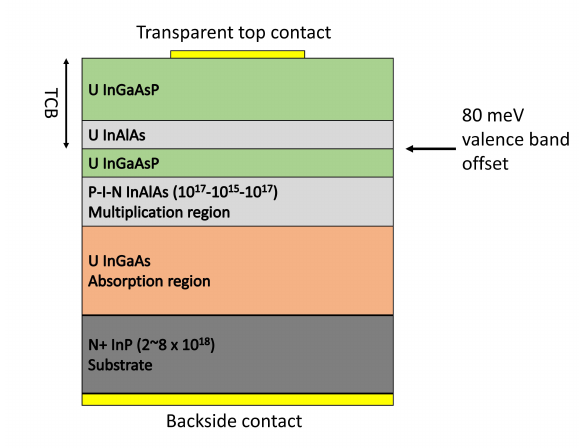
Figure 2: Epitaxial structure of a self-quenching InGaAs/InAlAs SPAD showing the InGaAs absorption region, InAlAs multiplication region, and InGaAsP-InAlAs TCB region. Adapted from